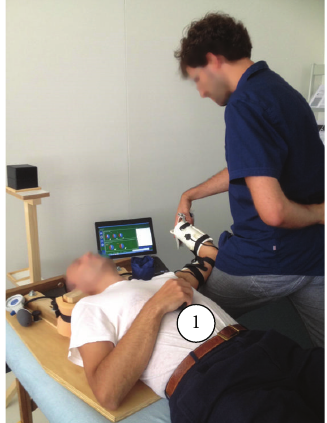
Figure 2: ULNT1 starting position. (1) Switch device held by the